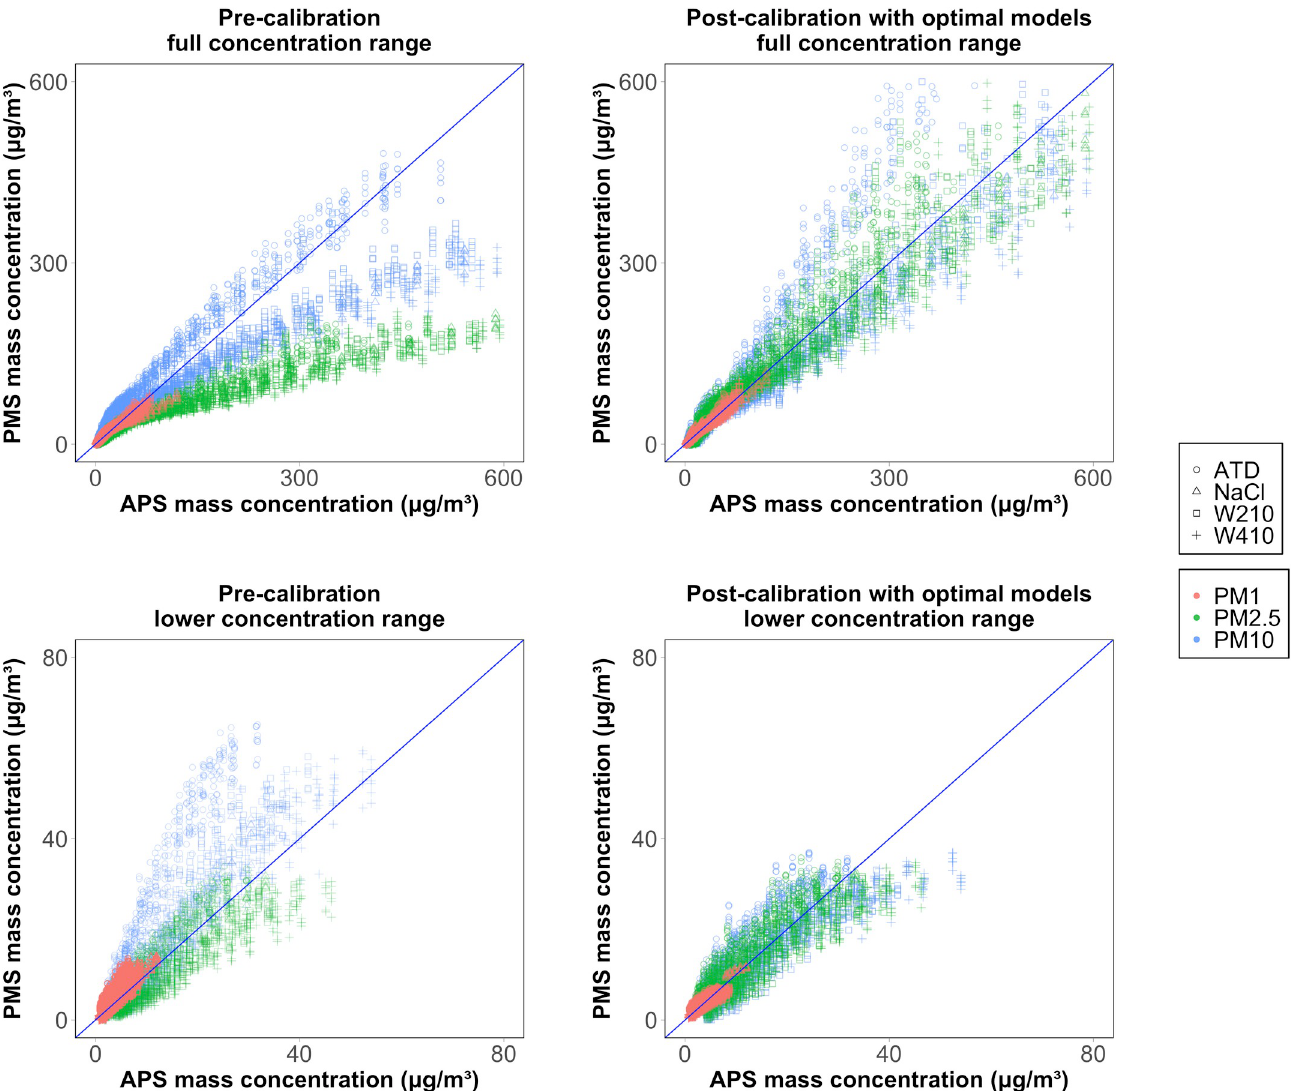
Fig 6. A comparison of the pre-calibrated and post-calibrated mass concentrations by full and lower concentration range. The blue line represents the 1:1 relationship between the PMS and APS